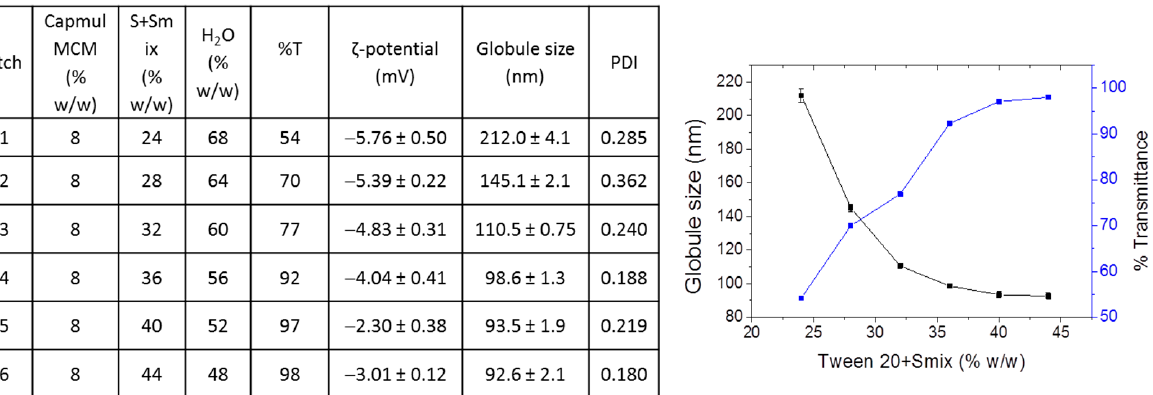
Figure 3. Physicochemical properties of the NEs composed of Tween 20 (as surfactant), with 8% Capmul MCM as the oil and various S + Smix percentages (from 24% up to 44%). Thereby, we decided to use 44% concentration of S + Smix. Comparison of various NE formulations with Tween 80 or Tween 20 as the surfactant was then realized (after preparing various formulations) for the identification of the best surfactant. The